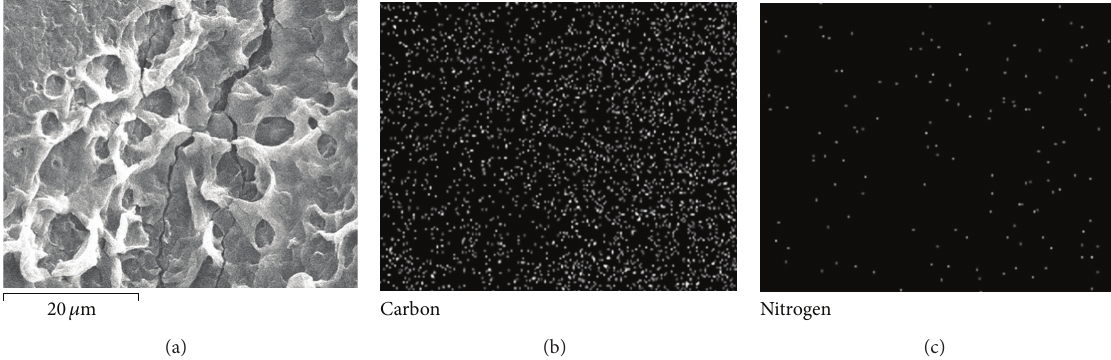
Figure 13: (a) SEM image and EDS distributions of (b) Carbon and (c) Nitrogen on the surface of the Ny 66-Co- o -NH 2